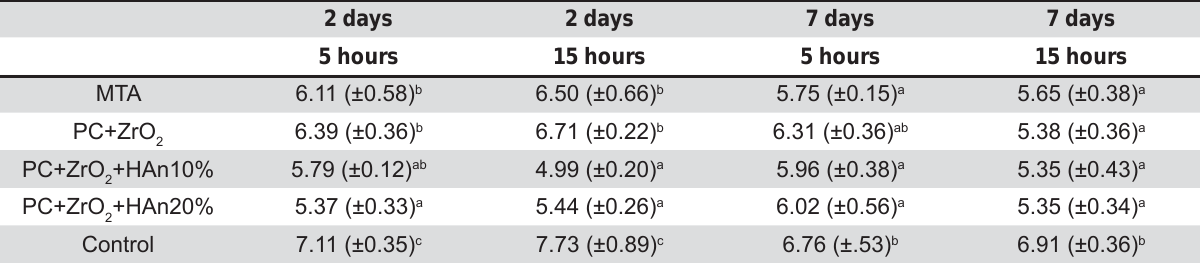
GUERREIRO-TANOMARU JM, VÁZQUEZ-GARCÍA FA, BOSSO-MARTELO R, BERNARDI MIB, FARIA G, TANOMARU-FILHO Table 3- (cid:48)(cid:72)(cid:68)(cid:81)(cid:3)(cid:89)(cid:68)(cid:79)(cid:88)(cid:72)(cid:86)(cid:3)(cid:11)(cid:38)(cid:41)(cid:56)(cid:3)(cid:80)(cid:47)(cid:16)(cid:20)(cid:12)(cid:3)(cid:68)(cid:81)(cid:71)(cid:3)(cid:86)(cid:87)(cid:68)(cid:81)(cid:71)(cid:68)(cid:85)(cid:71)(cid:3)(cid:71)(cid:72)(cid:89)(cid:76)(cid:68)(cid:87)(cid:76)(cid:82)(cid:81)(cid:3)(cid:73)(cid:82)(cid:85)(cid:3)(cid:68)(cid:81)(cid:87)(cid:76)(cid:69)(cid:76)(cid:82)(cid:191)(cid:79)(cid:80)(cid:3)(cid:68)(cid:70)(cid:87)(cid:76)(cid:89)(cid:76)(cid:87)(cid:92)(cid:3)(cid:72)(cid:89)(cid:68)(cid:79)(cid:88)(cid:68)(cid:87)(cid:76)(cid:82)(cid:81)